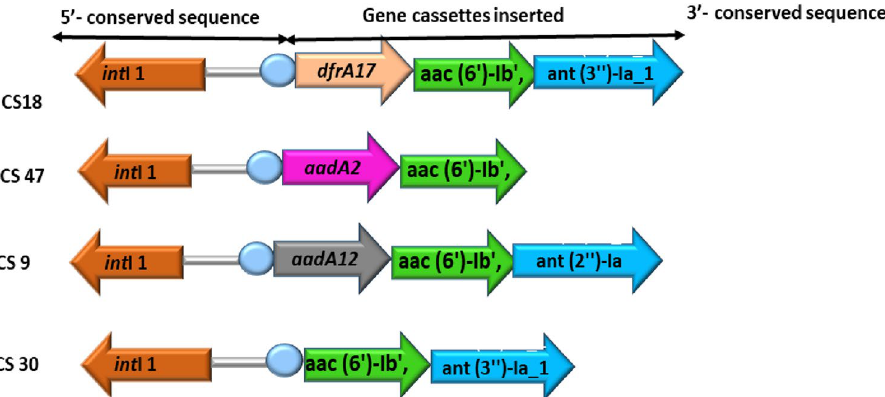
Figure 4. Schematic illustration of the gene cassette arrays within class 1 evaluated from A. baumanni from this study. “(dfrA12), dihydrofolate reductase; aminoglycoside 6’-N-acetyltransferase gene ( aac (6’)-Ib ′ ) genes, Aminoglycoside-2 ″ -O-nucleotidyltransferase ( ant (2’’)-Ia and aminoglycoside (3’’) (9) adenylyltransferase (aadA2) genes”.